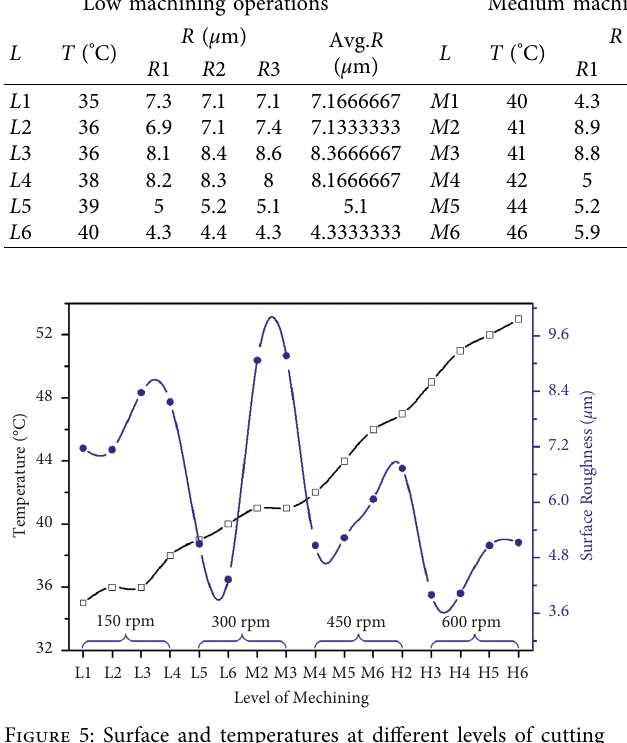
Table 9: Surface roughness ( R ) of wet machining operation (without adding solid lubricant). Wet machining operation (20% of coconut oil+bio-diesel without adding solid lubricant)